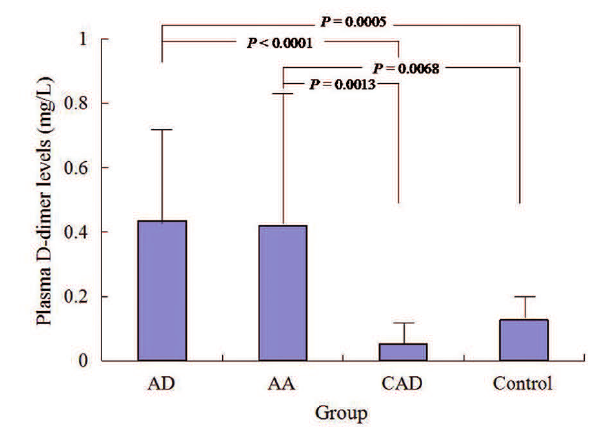
Fig. 1. Plasma D-dimer levels. AA - aortic aneurysm; AD - aortic dissection; CAD - coronary artery disease; Control - healthy